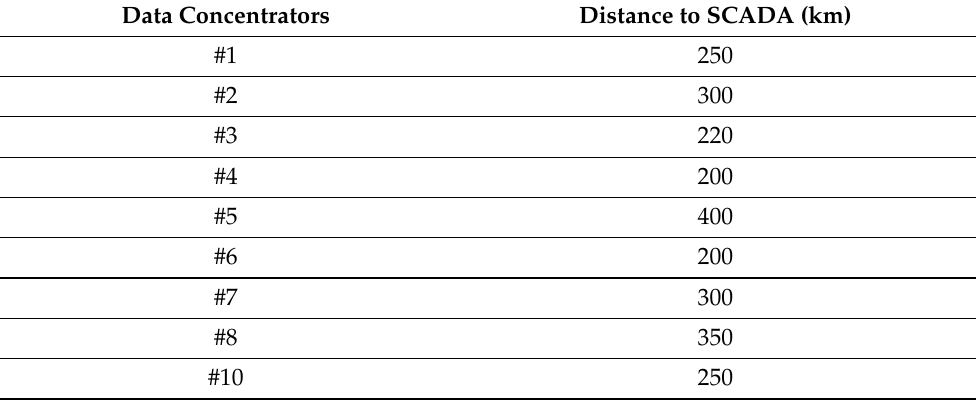
Table A2. SCADA (cid:29) #Y data